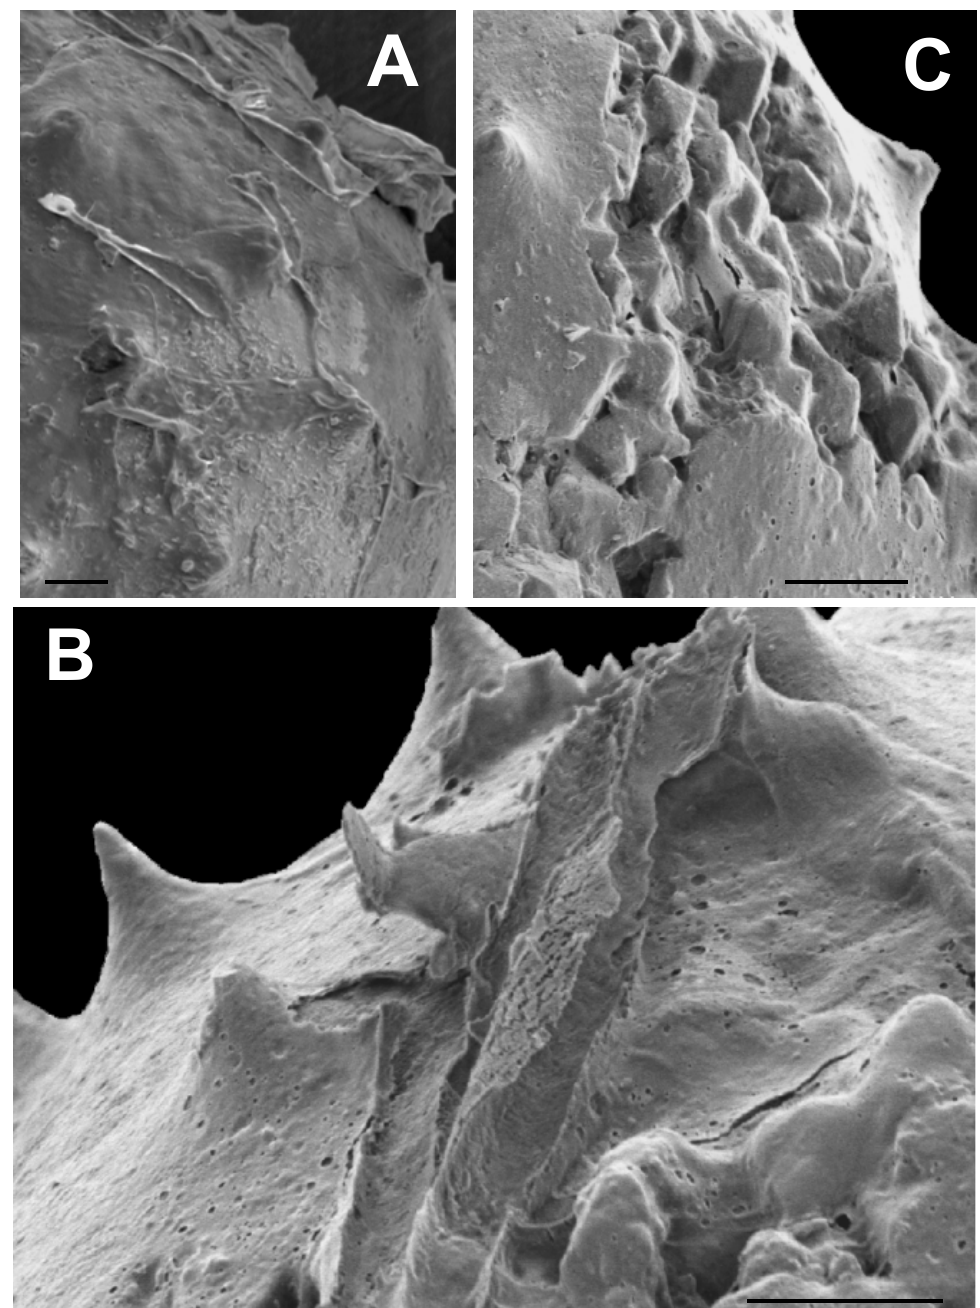
Figure 11. Microalgae having a thin, coating or layer at the surface. All scale bars = 10 µm. ( A ) SEM image of an acanthomorphic specimen (TYS-40) having a thin surface layer which has split away from the surface. The edges of this layer turn up, and in places form long tube-like rolls; ( B ) SEM image of an acanthomorphic specimen (TYS-51) showing that this layer contains numerous ovate or circular pits similar in appearance to collapsed air bubbles; ( C ) SEM image of an acanthomorphic specimen (TYS-44) which has split open revealing pyrite crystals within the interior. A well-developed thin, pitted layer is visible covering the surface of the specimen at the lower right and upper left, and extending across the tips and exposed surfaces of the interior crystals.